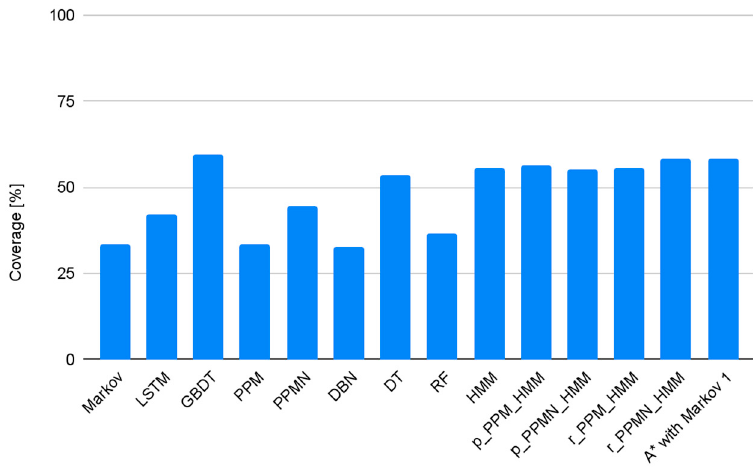
Figure 11. Coverage on the students’ dataset.